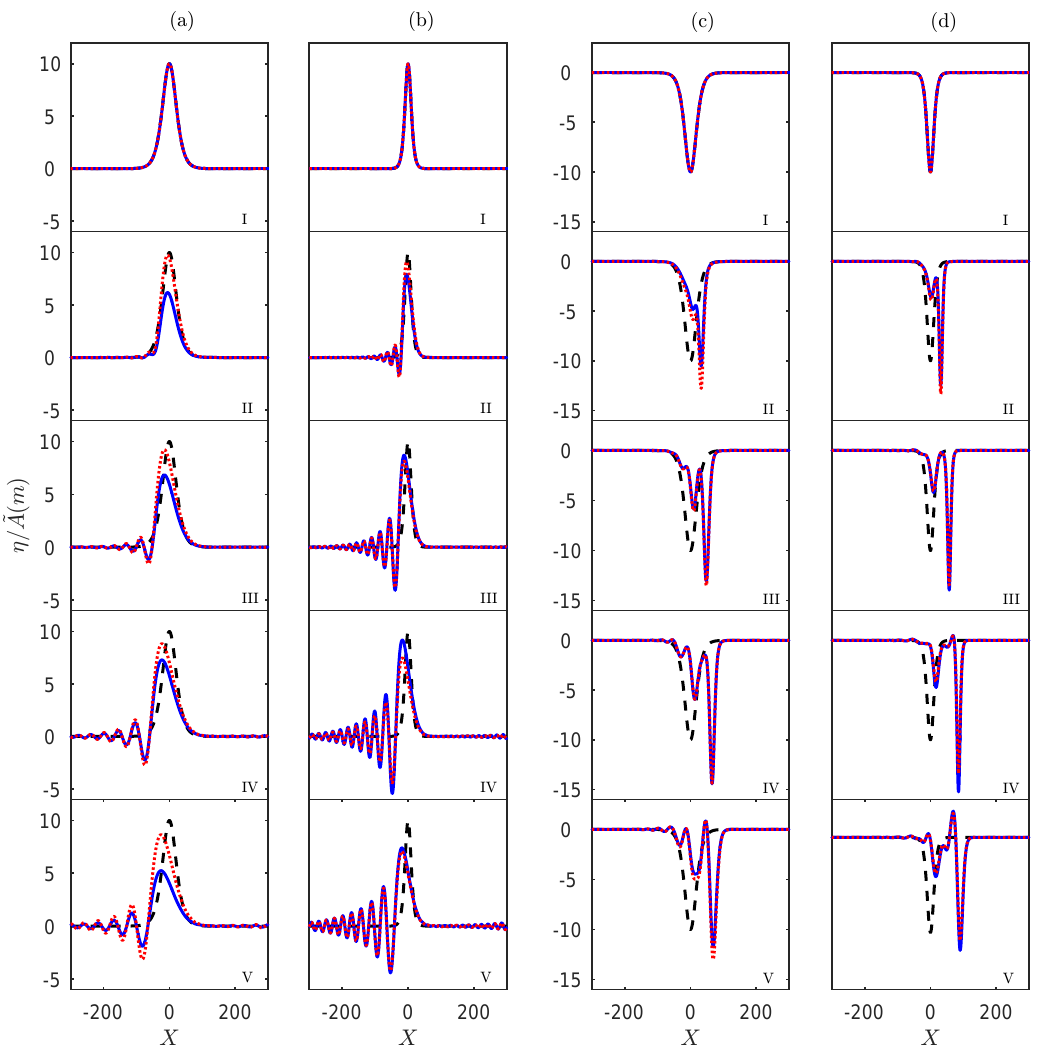
Figure 13. A numerical simulation of the vKdV Equation (5) of a transect along the Malvinas Current case in summer ( a , b ) and winter ( c , d ) conditions, with u 0 = 0 ( a , c ) or u 0 (cid:54) = 0 ( b , d ), respectively. The initial condition is the solitary wave (black, dash), the numerical solution is ˜ A (red, dot) and the physical solution is η (blue, solid). From top to bottom, the distances from the initial point are (I) 0 km, (II) 36.5 km, (III) 73 km, (IV) 109.5 km, (V) 146 km,